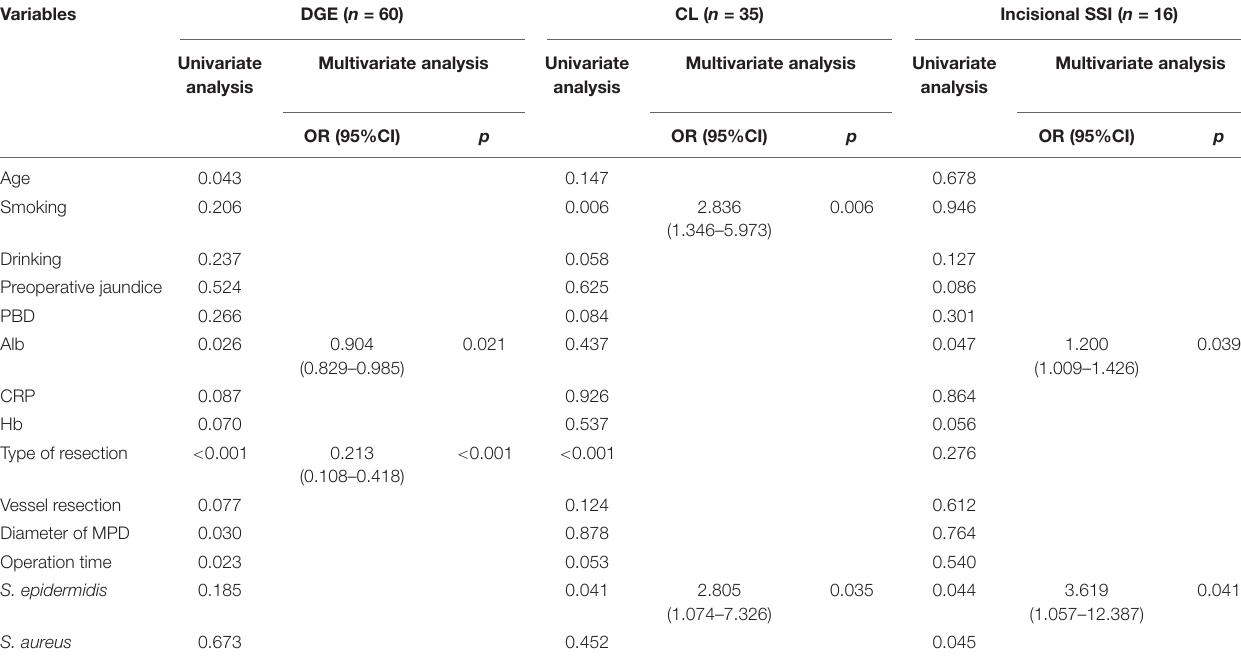
TABLE 6 | Univariate and multivariate analysis for risk factors of non-sever complication.